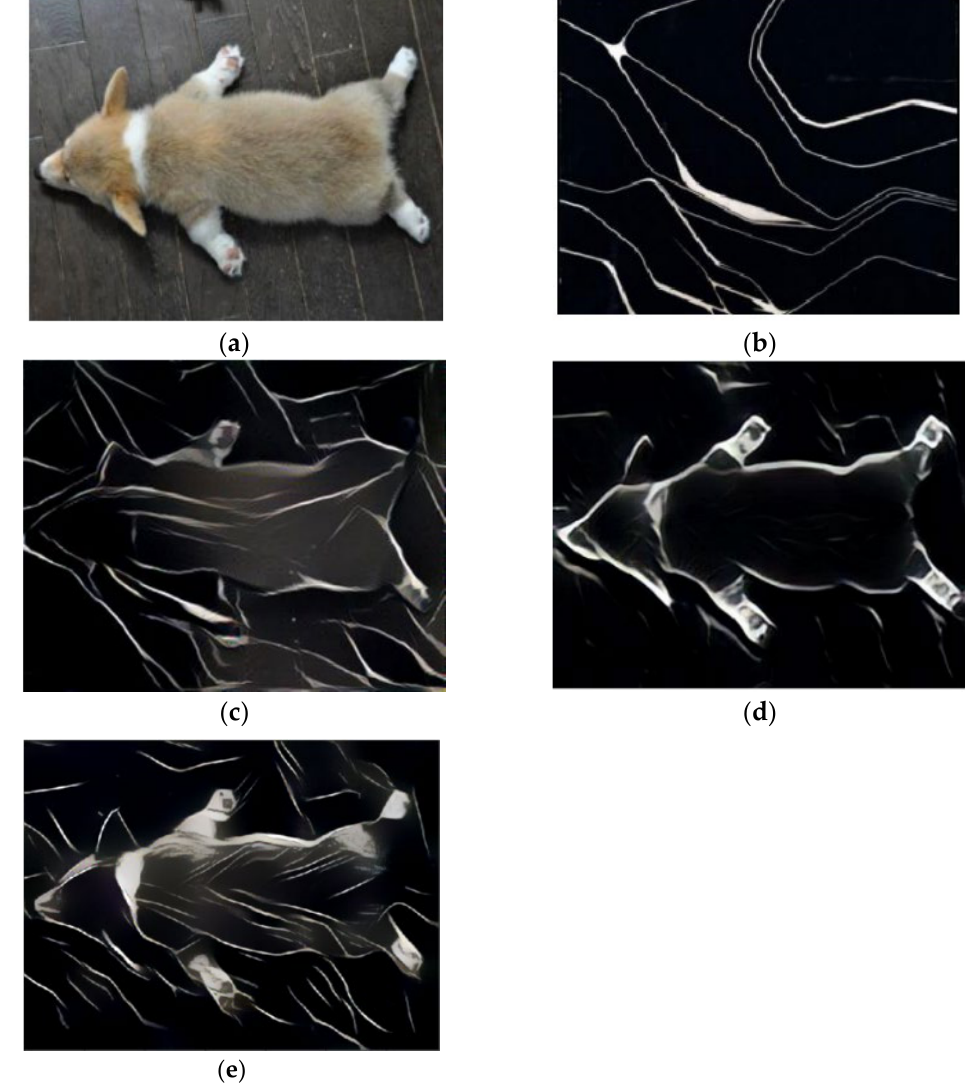
Figure 20. The comparison of Gatys et al.’s method, X. Li et al.’s method, and the proposed method. ( a ) Content image. ( b ) Target image. ( c ) The results of Gatys et al.’s method. ( d ) The results of X. Li et al.’s method. ( e ) Our result.